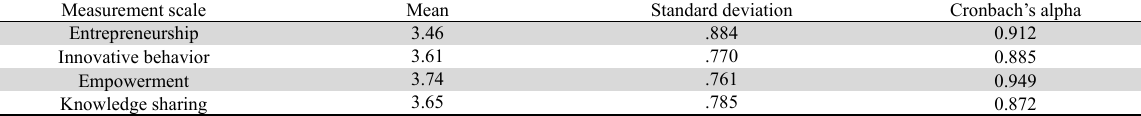
Cronbach’s alpha and descriptive statistics of the measurement